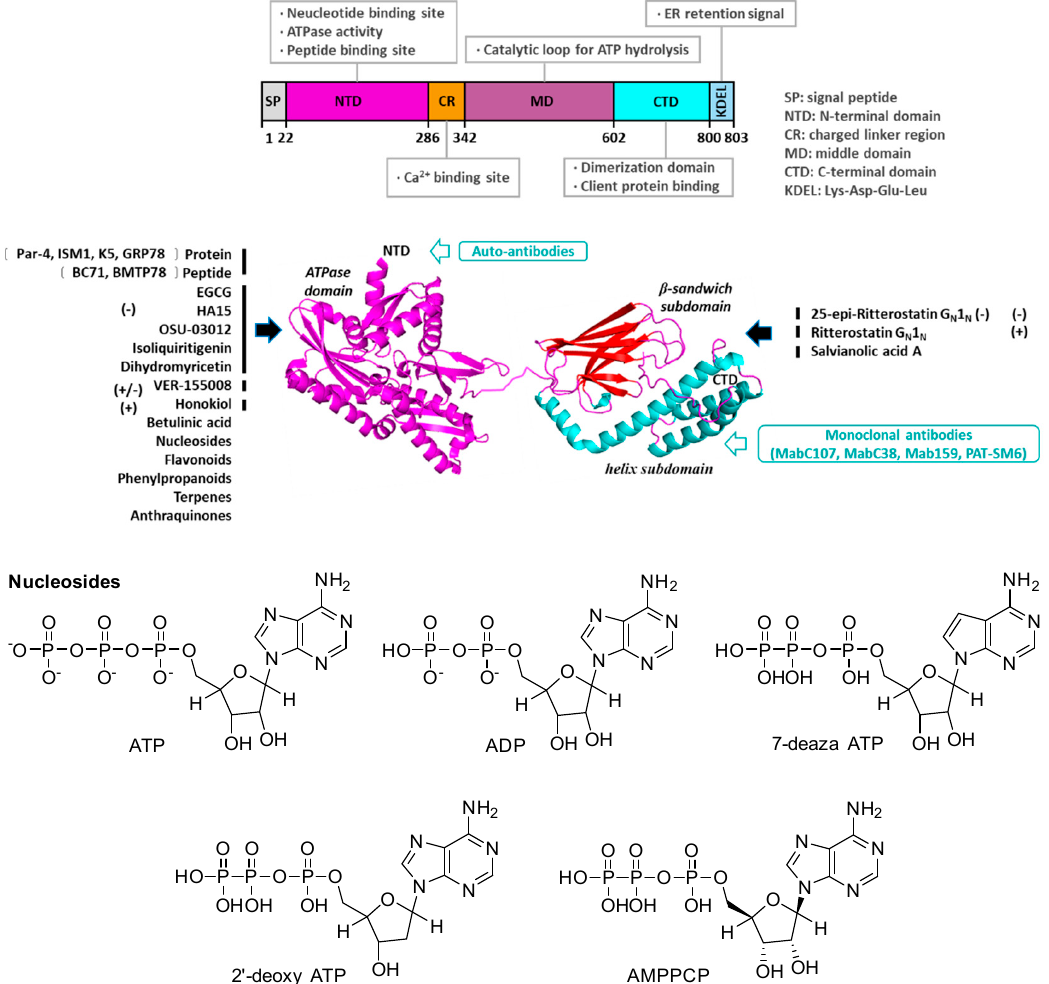
Figure 4. Regulatory functions of GRP78 and downstream molecular functions relevant to anti-obesity. Domain structures ( top ) and 3D structural model ( middle ) of GRP78, molecules interacting with either the ATPase domain (in magenta), β sandwich subdomain (in red) or the helix subdomain (in cyan) of GRP78, and chemical structures of nucleosides ( bottom ). The cited small molecules can up (+) or down ( − ) regulate GRP78. Modi fi ed from [72].